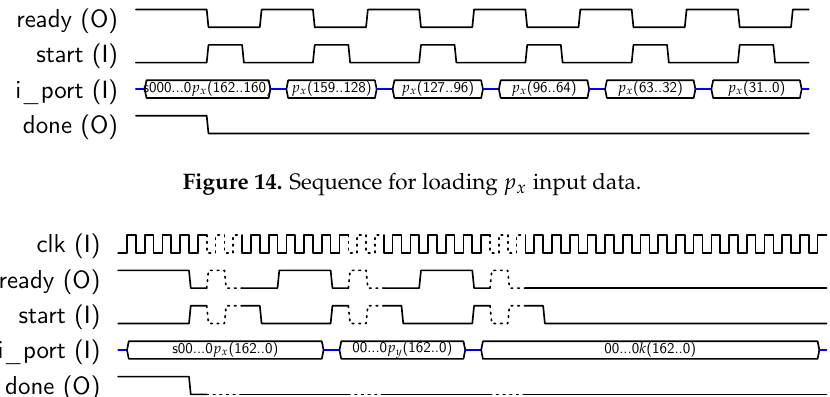
Figure 15. Sequence for loading p x , p y , q x and q y